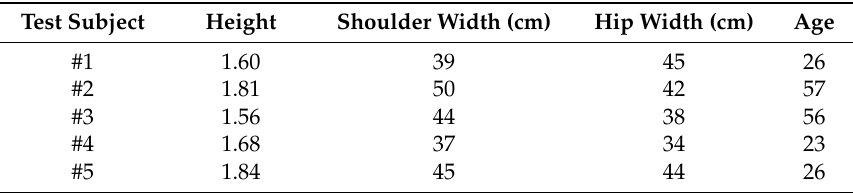
Table A2. Test Subjects Corporal